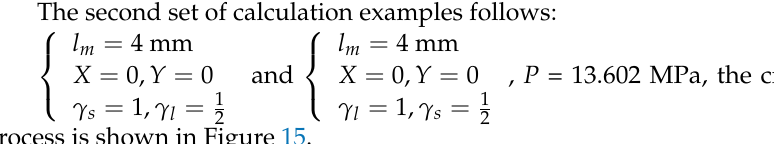
process is shown in Figure